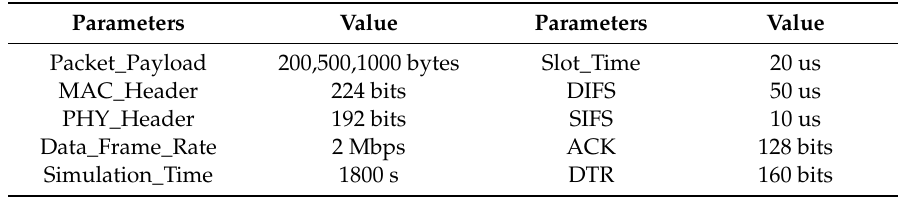
Table 1. Simulation